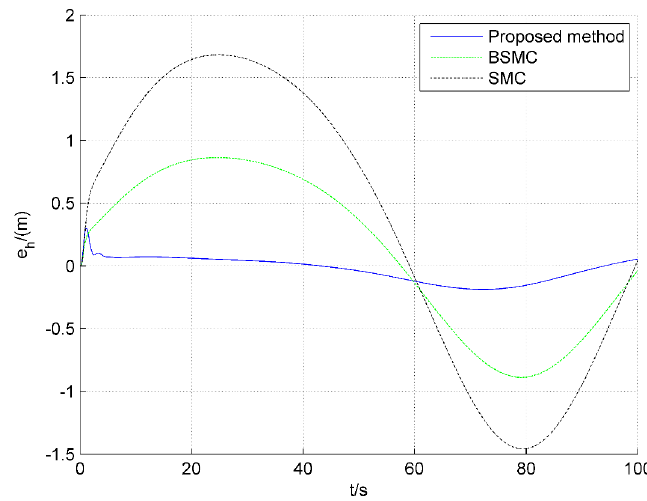
Figure 6. Responses of altitude tracking.